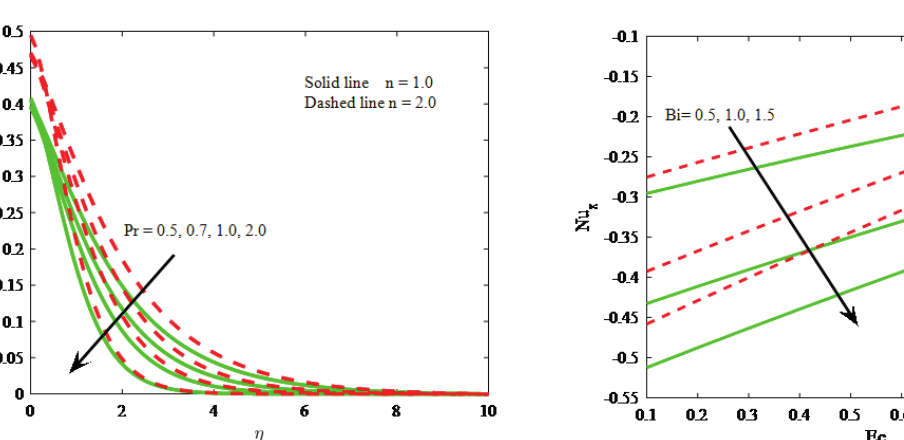
Fig. 16: Impacts of Ec and Bi on friction factor.